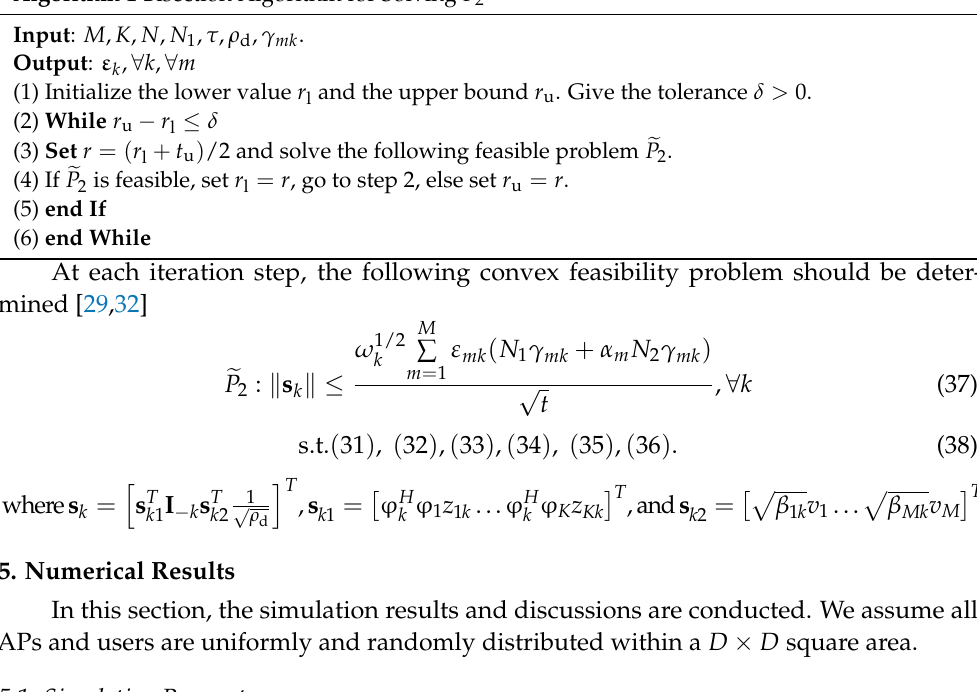
Algorithm 1 Bisection Algorithm for Solving P